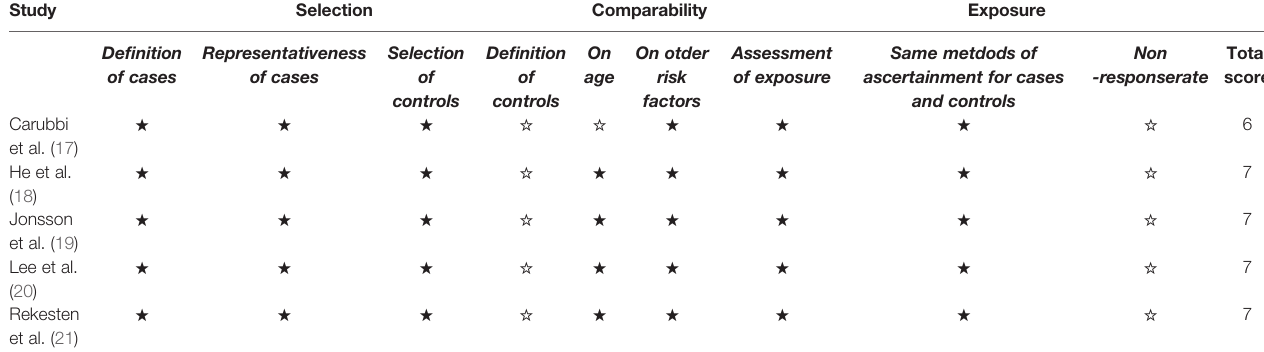
TABLE 2 | Newcastle-Ottawa Assessment